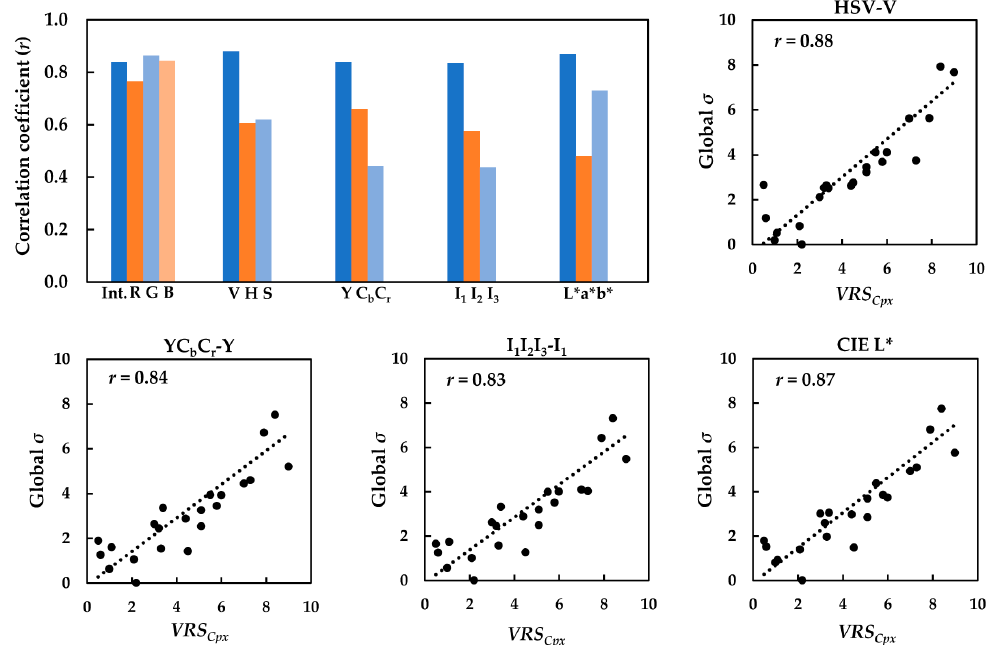
Figure 11. The correlation between the VRS Cpx of the textiles and global σ of the luminance and chrominance channels of the textile images in the sRGB, HSV, YC b C r , I 1 I 2 I 3 and CIELAB color spaces. Here, ‘Int.’ refers to the sRGB intensity image (top left). Scatter plots of the global σ versus the corresponding VRS Cpx for the luminance channel of the textile images in the HSV, YC b C r , I 1 I 2 I 3 , and CIELAB color spaces.